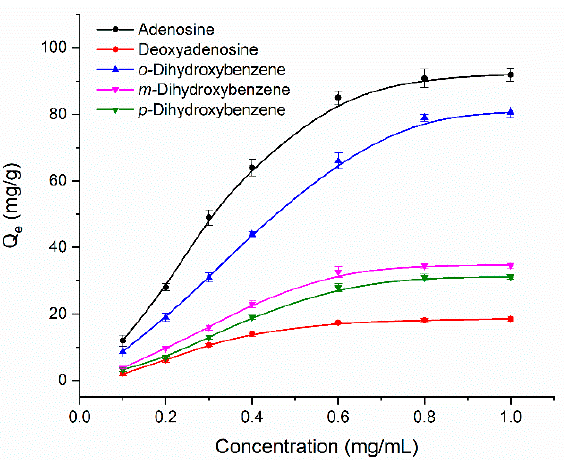
Figure 7. Adsorption isothermal curves of Fe 3 O 4 @MPTES@VPBA.